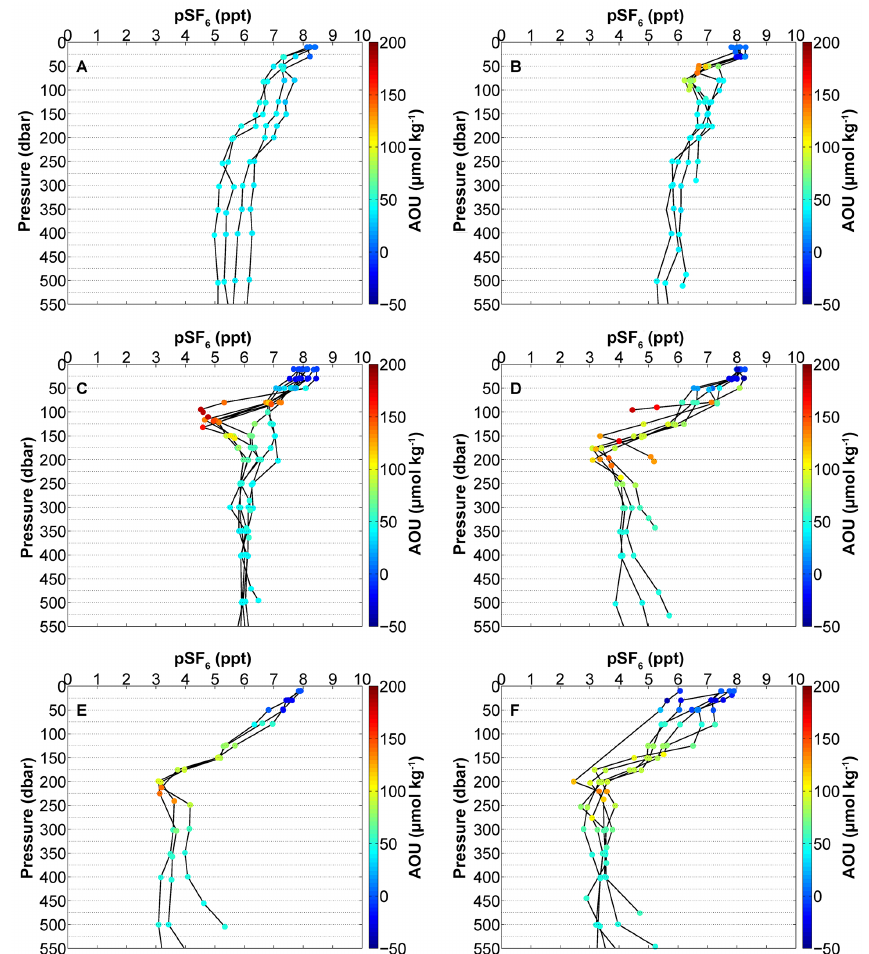
Figure 5. pSF 6 (ppt per volume) profiles from surface to 550m depth, coloured by AOU (µmolkg − 1 ) of the stations in sections A to F.